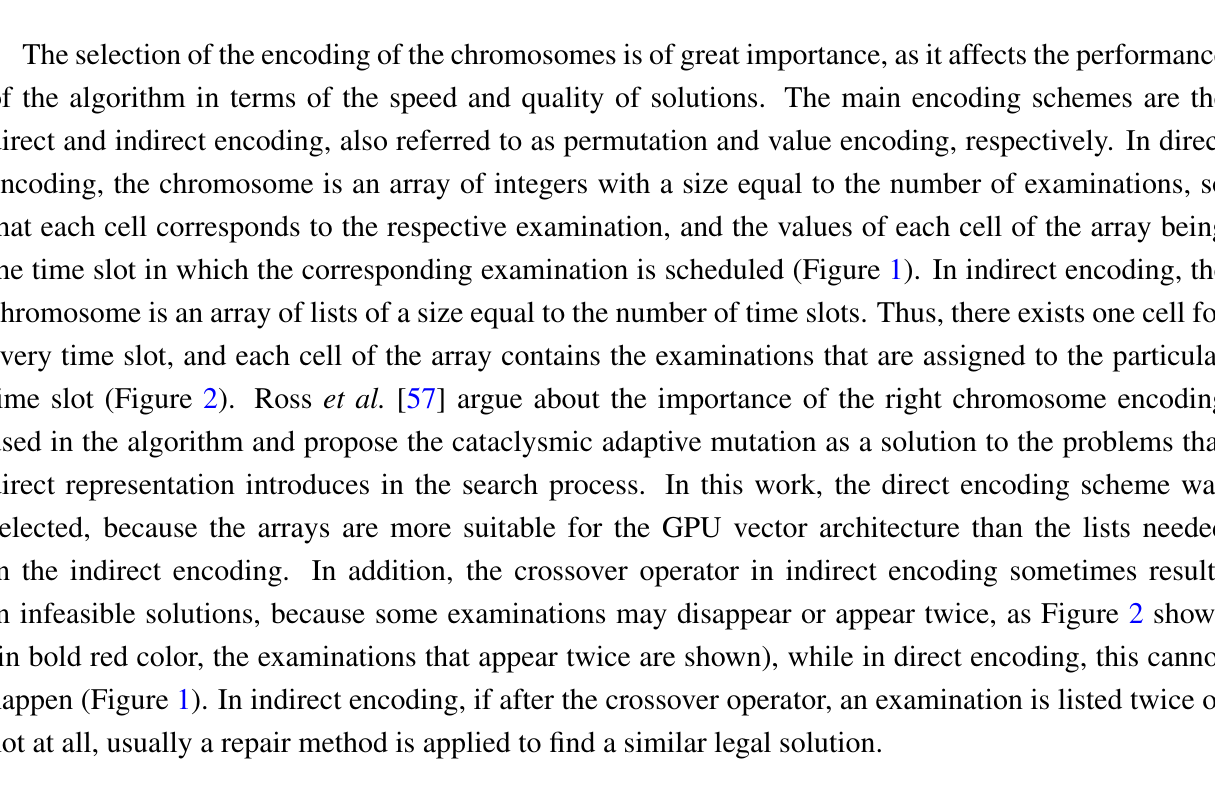
Figure 1. Direct encoding: single-point crossover between two chromosomes after the second gene. E1–E5: examinations; T1–T3: